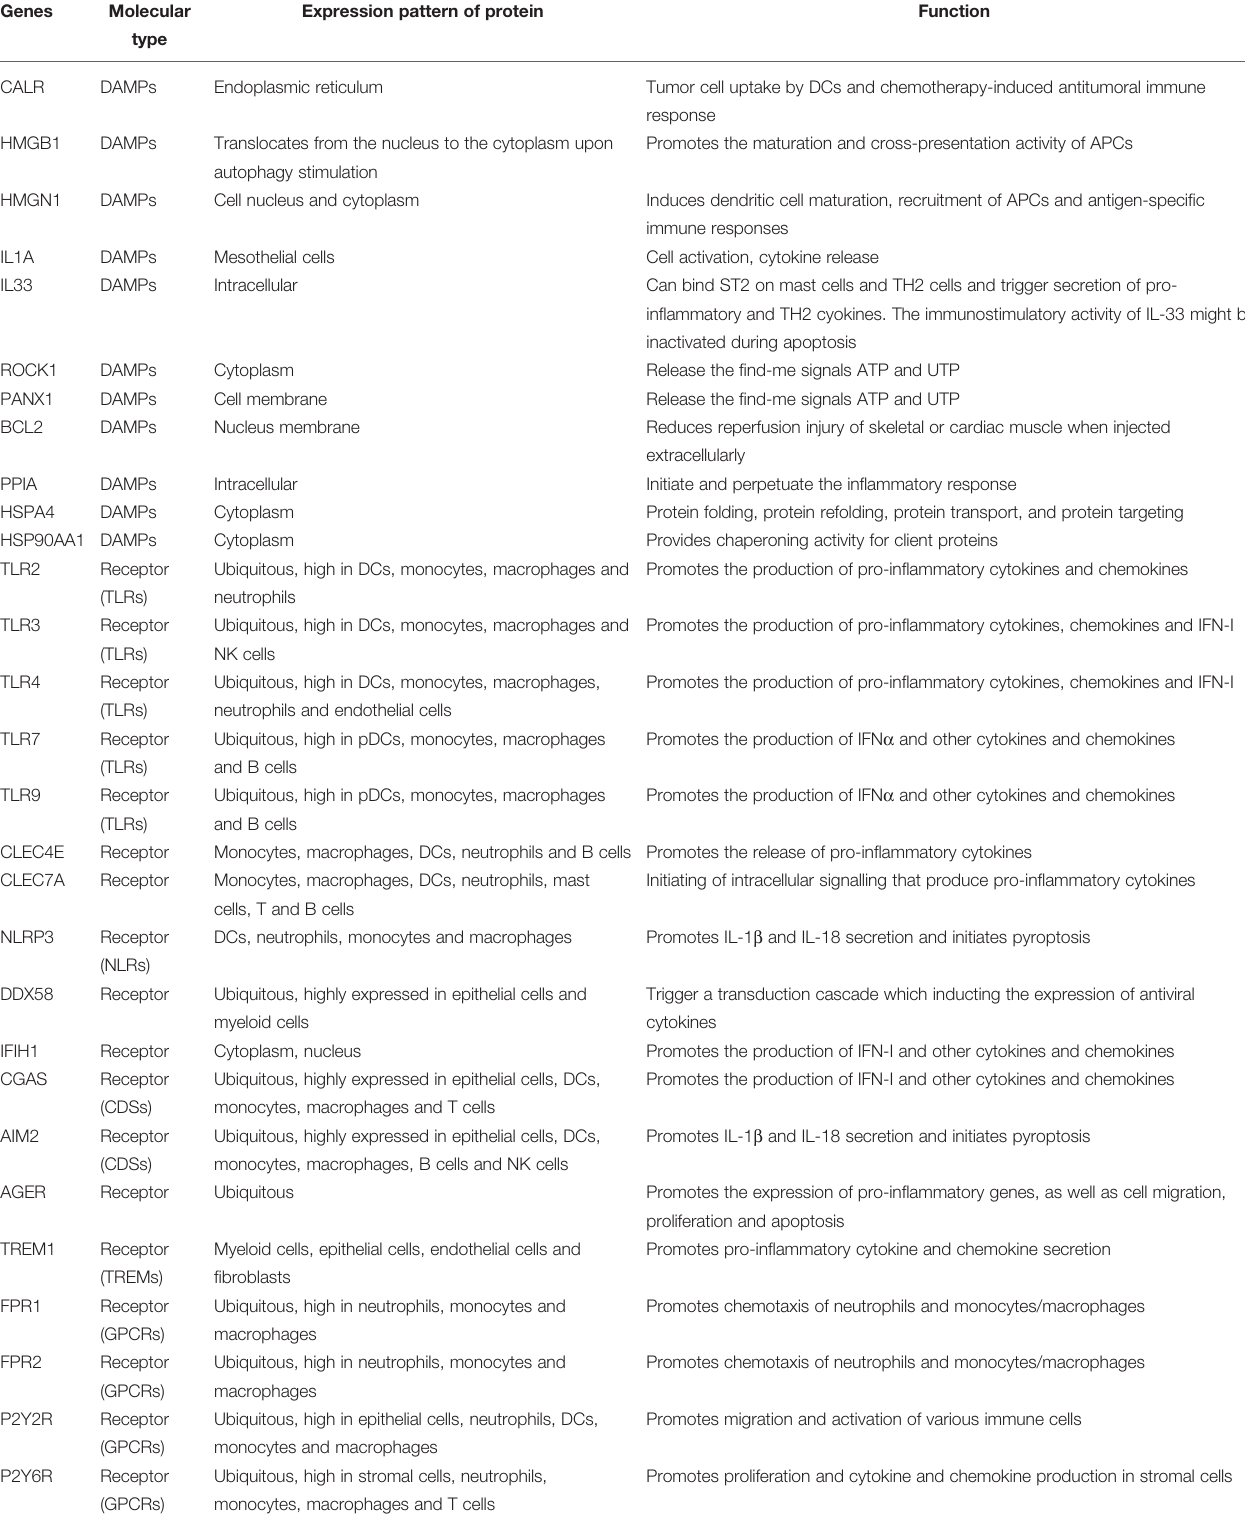
TABLE 2 | DAMPs-related genes (9, 12, 23,